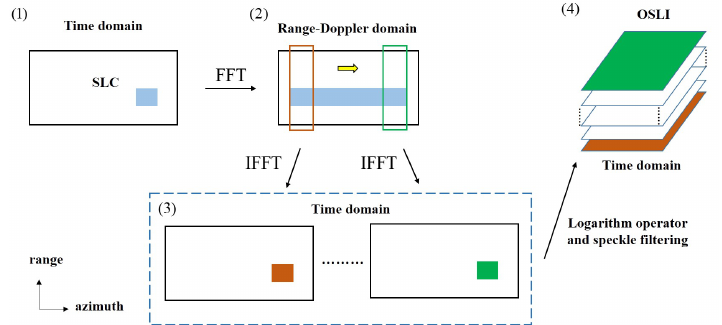
Figure 7. The illustration of subaperture